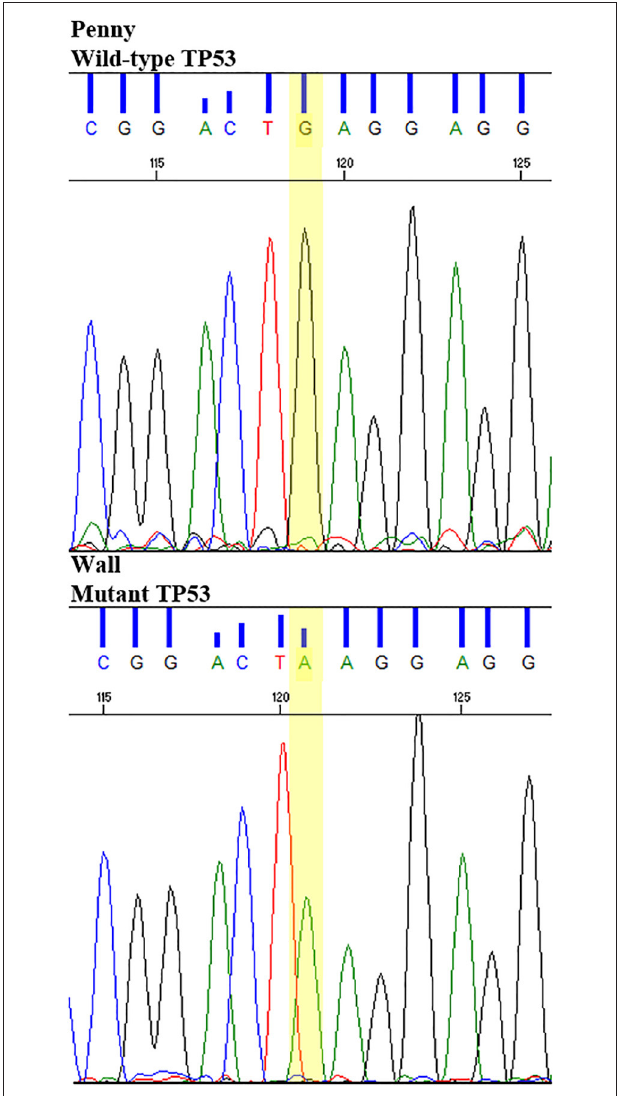
FIGURE 7 | Sanger sequencing of TP53 E273K mutation in the Wall cell line and primary FFPE tumor, compared to wild-type TP53 Penny cell line and the reference canine TP53